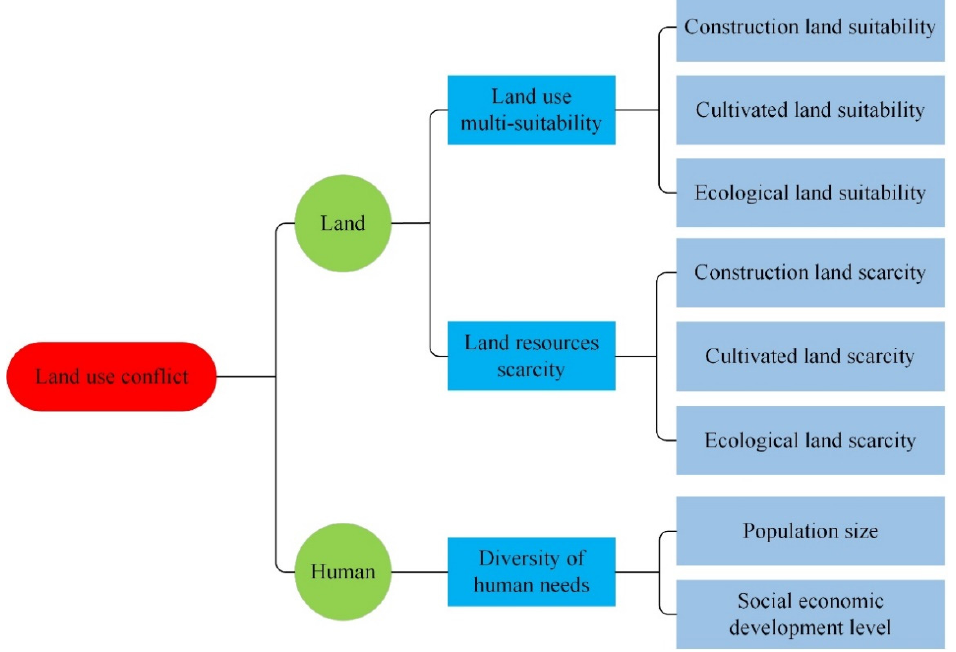
Figure 1. Conceptual framework for land use conflict identification.